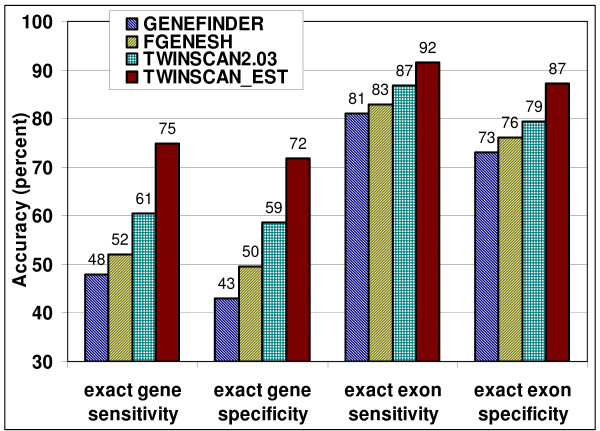
Results on the whole C. elegans genome (version WS130) using C. briggsae (version cb25.apg8) as the informant database and C. elegans ESTs from dbEST. The sensitivities are based on the 4,705 fully confirmed genes from WS130 and the specificities are based on those predictions that overlap with fully confirmed genes.